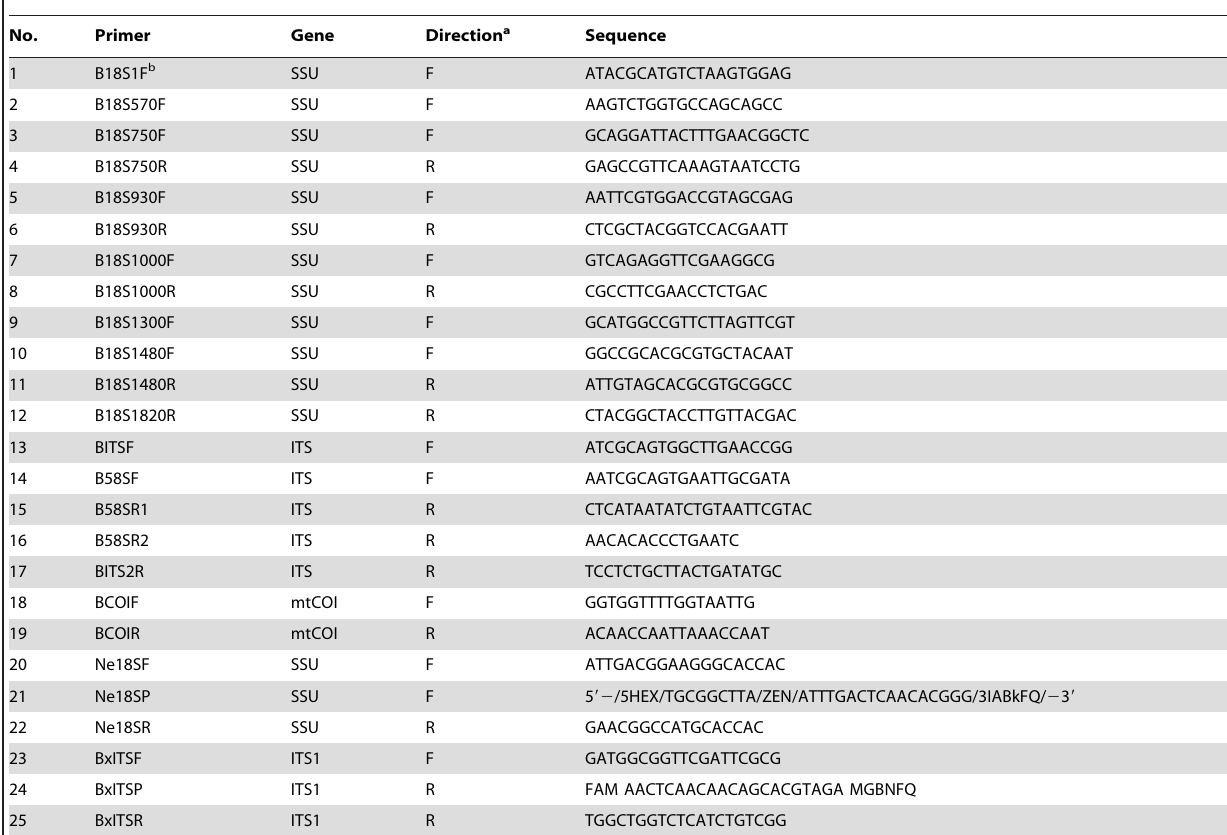
Table 2. PCR Primers and Real-Time PCR Primers and Probes.